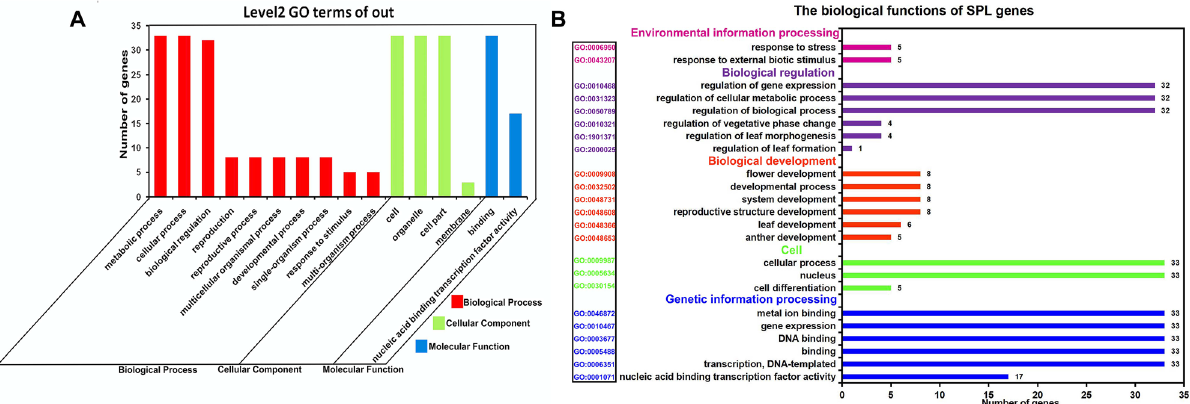
Figure 4. GO annotation of identified SPL TFs in three categories: biological processes, cellular components, and molecular functions. ( A ) GO enrichment. ( B ) Prediction of biological functions. This figure was generated by gogseasenior (https:// www. omics hare. com/ tools/ Home/ Soft/ gogse aseni